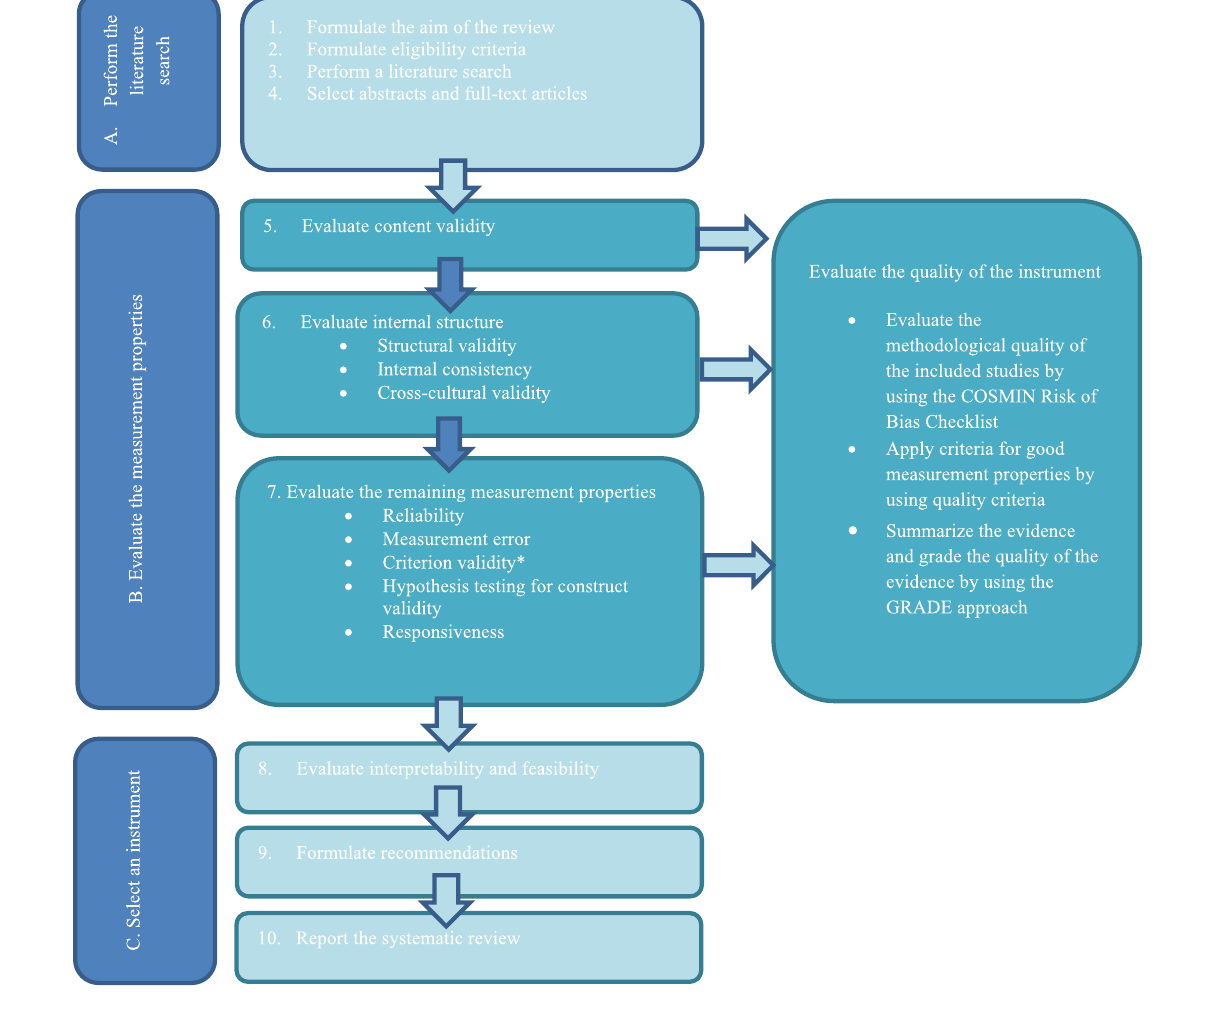
FIGURE 1 | COnsensus-based Standards for the selection of health Measurement INstruments (COSMIN) guideline for systematic reviews of health-related measurement instruments. Reprint of this figure from Prinsen et al. (2018) is permitted under the Creative Commons Attribution 4.0. (http://creativecommons.org/licenses/by/4.0/). The acronym PROM (Patient Rated Outcome Instrument) is changed to “instrument” in this reprint. *Criterion validity was not assessed in this review, as no gold-standard instrument for comparison was